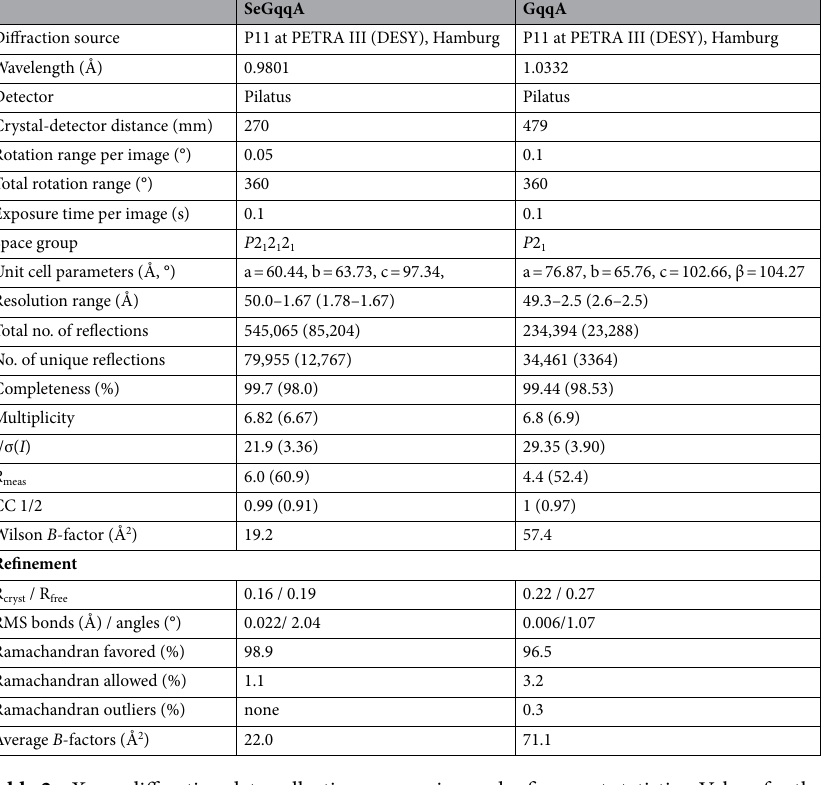
Table 2. X-ray diffraction data collection, processing and refinement statistics. Values for the outer resolution shell are given in